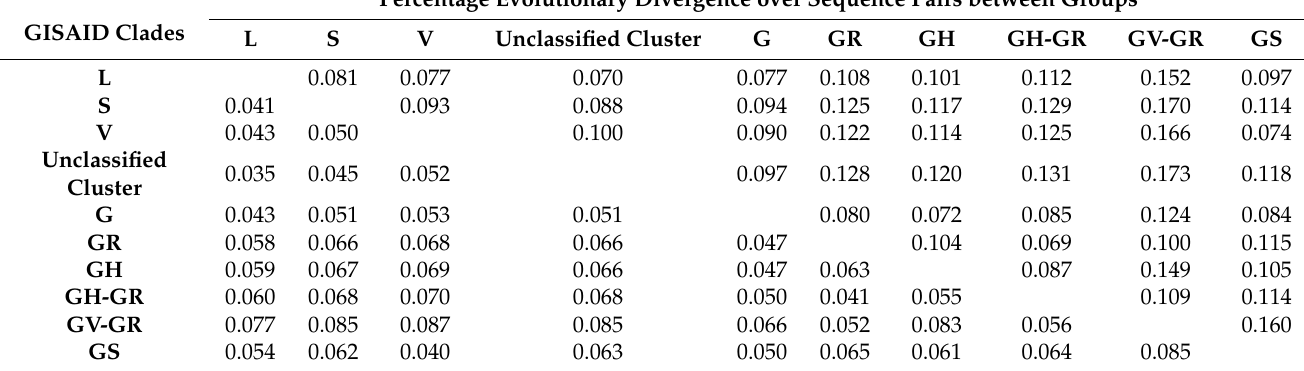
Table 1. Percentage nucleotide and amino acid evolutionary divergence over Sequence Pairs between different GISAID groups, using the P distance along with uniform distribution as the rate variation parameter among sites.